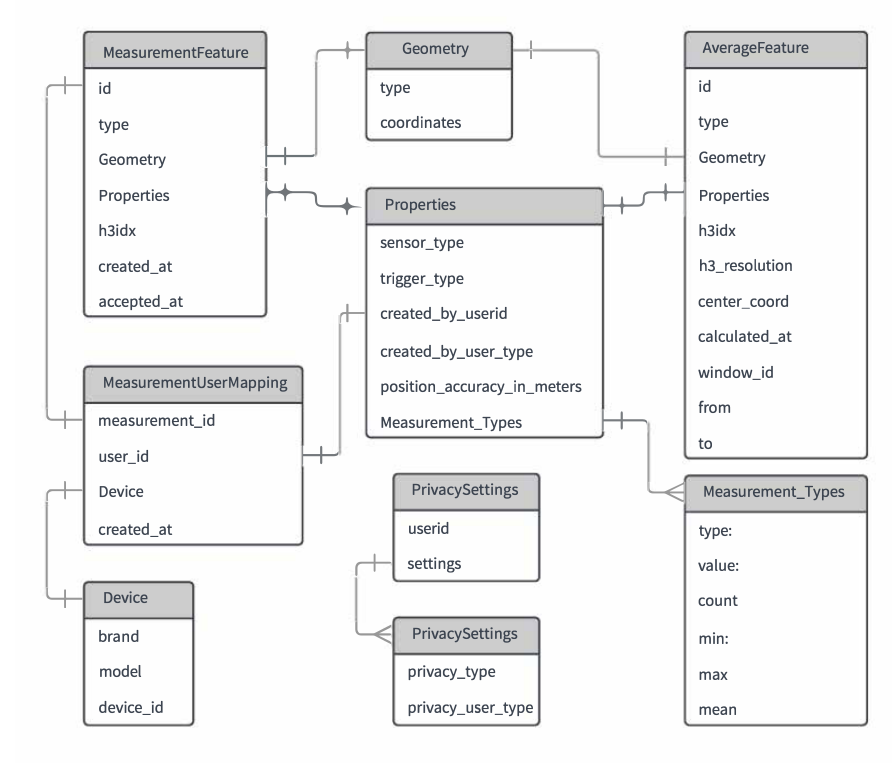
Figure 5. Data model for noise measurements. Reproduced with permission from Kraft et al., In Proceedings of the 2019 IEEE 32nd International Symposium on Computer-Based Medical Systems (CBMS); published by IEEE, 2019